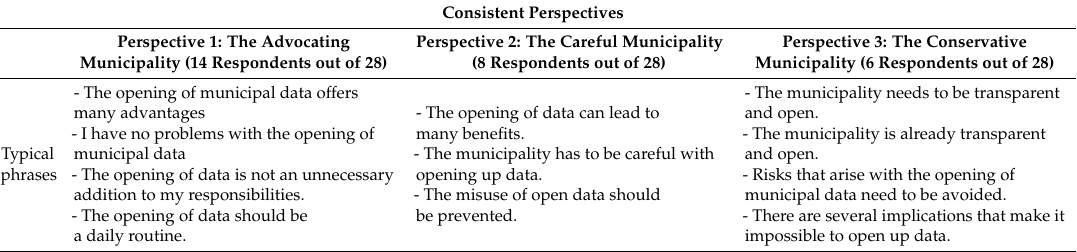
Table 3. Selection of respondents in municipalities of different